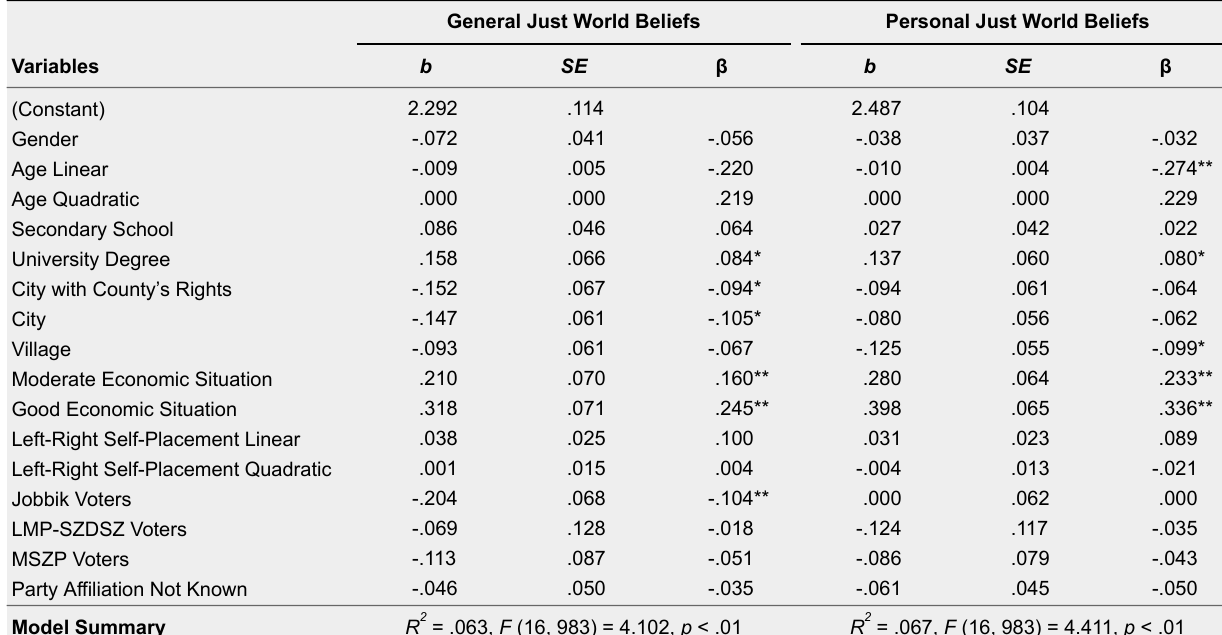
Multiple Regression Analyses After the Second Set of Predictors (Political Predictors) Were Added to the Model. Dependent Variables: General Just World Beliefs and Personal Just World Beliefs (N = 1000)